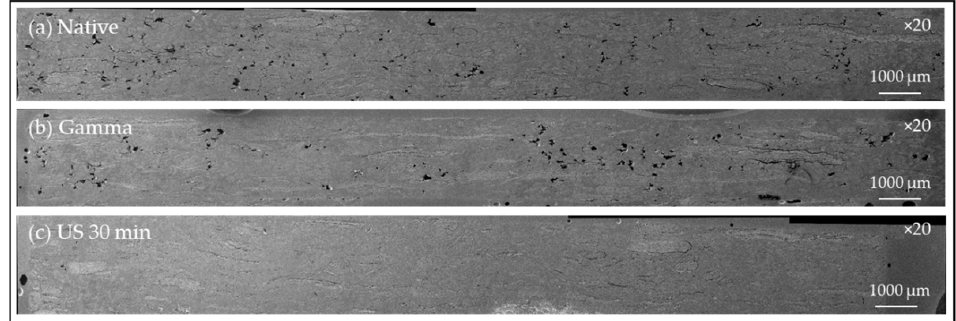
Figure 9. SEM observations of non-woven composites ( a ) Native; ( b ) Gamma; ( c ) US 30 min.